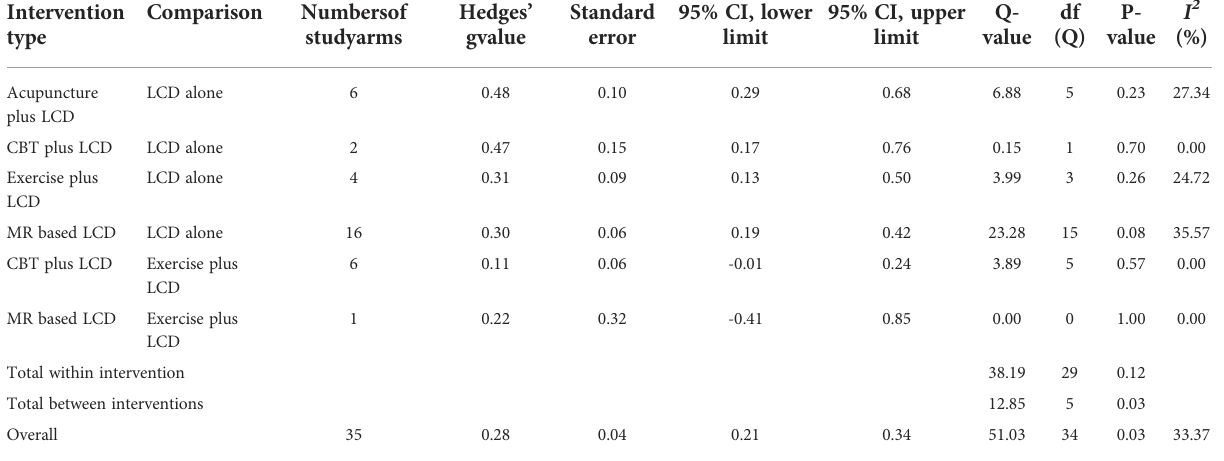
TABLE 3 Test of heterogeneity in the BMI or weight of pairwise meta-analysis assessed by Q-test and I 2 statistics. Intervention type